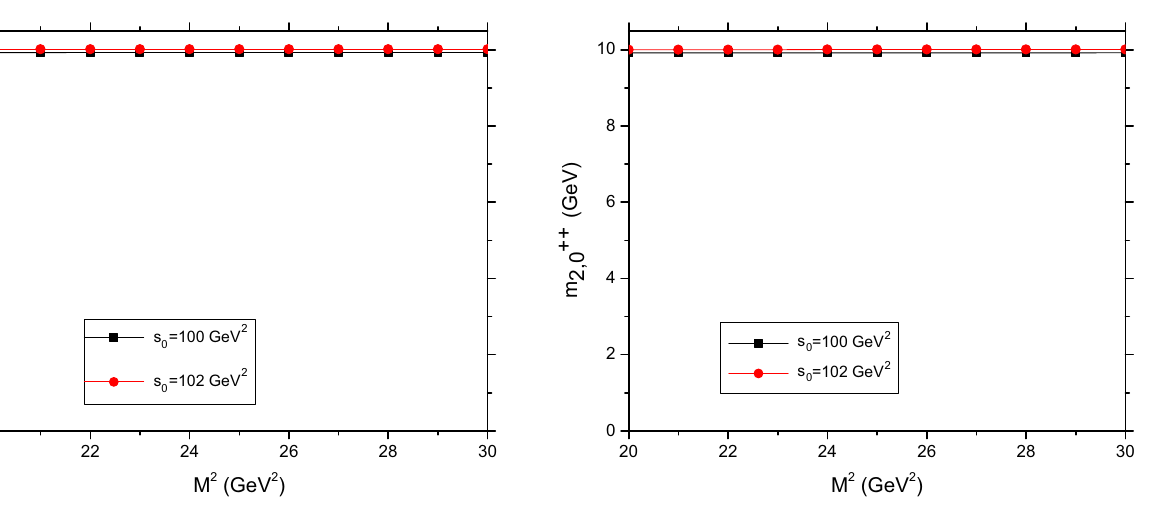
Fig. 9 Borel parameter dependence of J PC = 0 ++ meson mass from (cid:10) ( 2 ) μναβ for different s 0 values